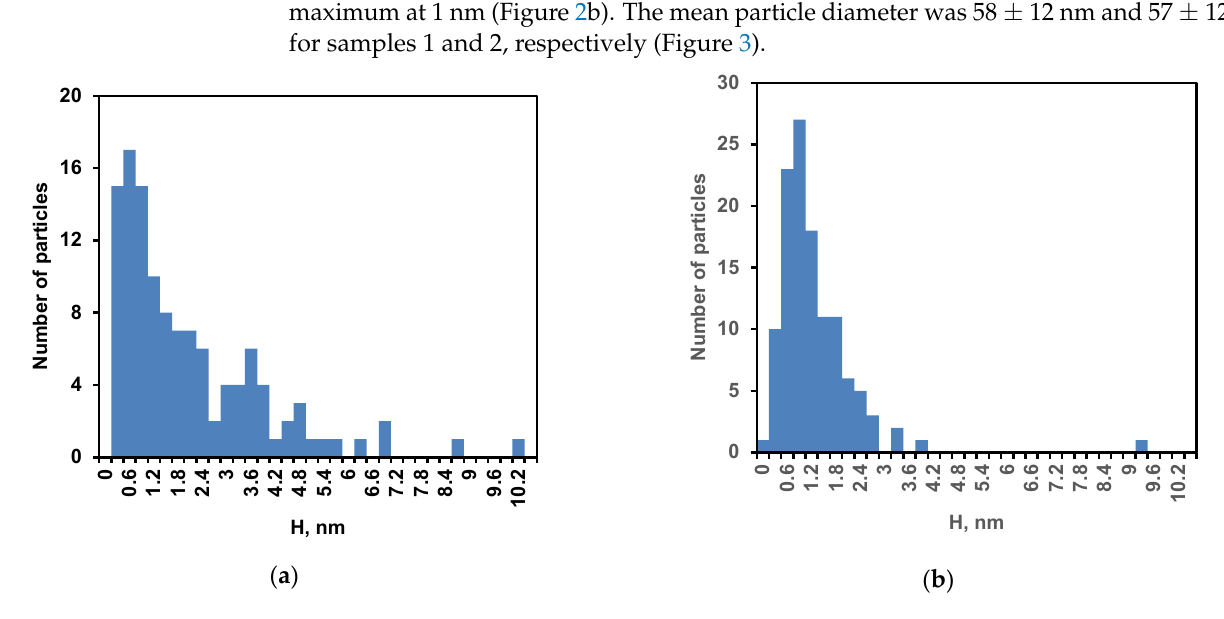
Figure 2. Height distribution of nanoparticles: ( a ) sample 1 obtained with heat inactivation of trypsin